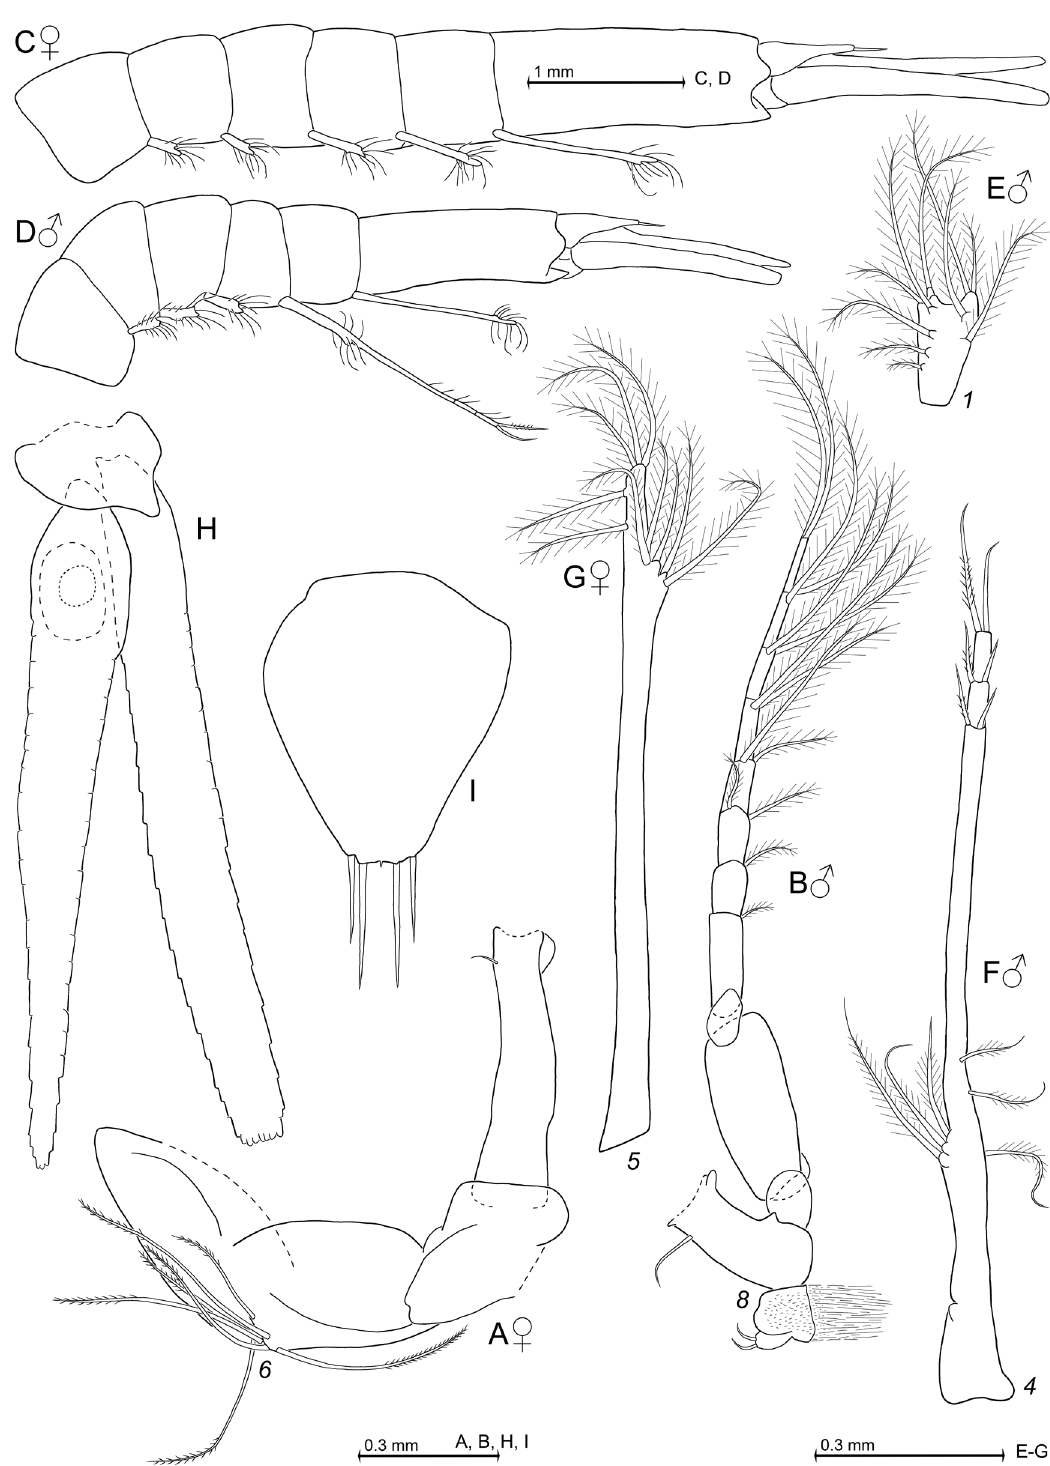
Fig. 7. Abyssomysis cornuta gen. et sp. nov., holotype, adult male with body length 6.6 mm (D: ZMH 58250), paratypes female 7.9 mm (A, C, G: ZMH 58256) and males 6.7 mm (B, F: ZMH 58254), 6.8 mm (E, H–I: SMF 55190). A . Sixth thoracic sympod with oostegite. B . Eighth thoracic sympod with exopod and penis. C–D . Pleon in female (C) and male (D), lateral. E . First male pleopod. F . Fourth male pleopod. G . Fifth female pleopod. H . Uropods, ventral. I .